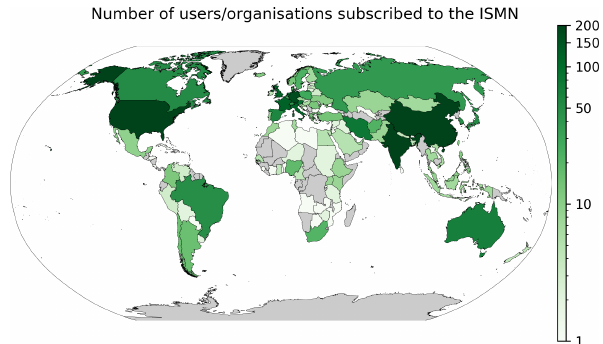
Figure 9. Number of users per country (status in July